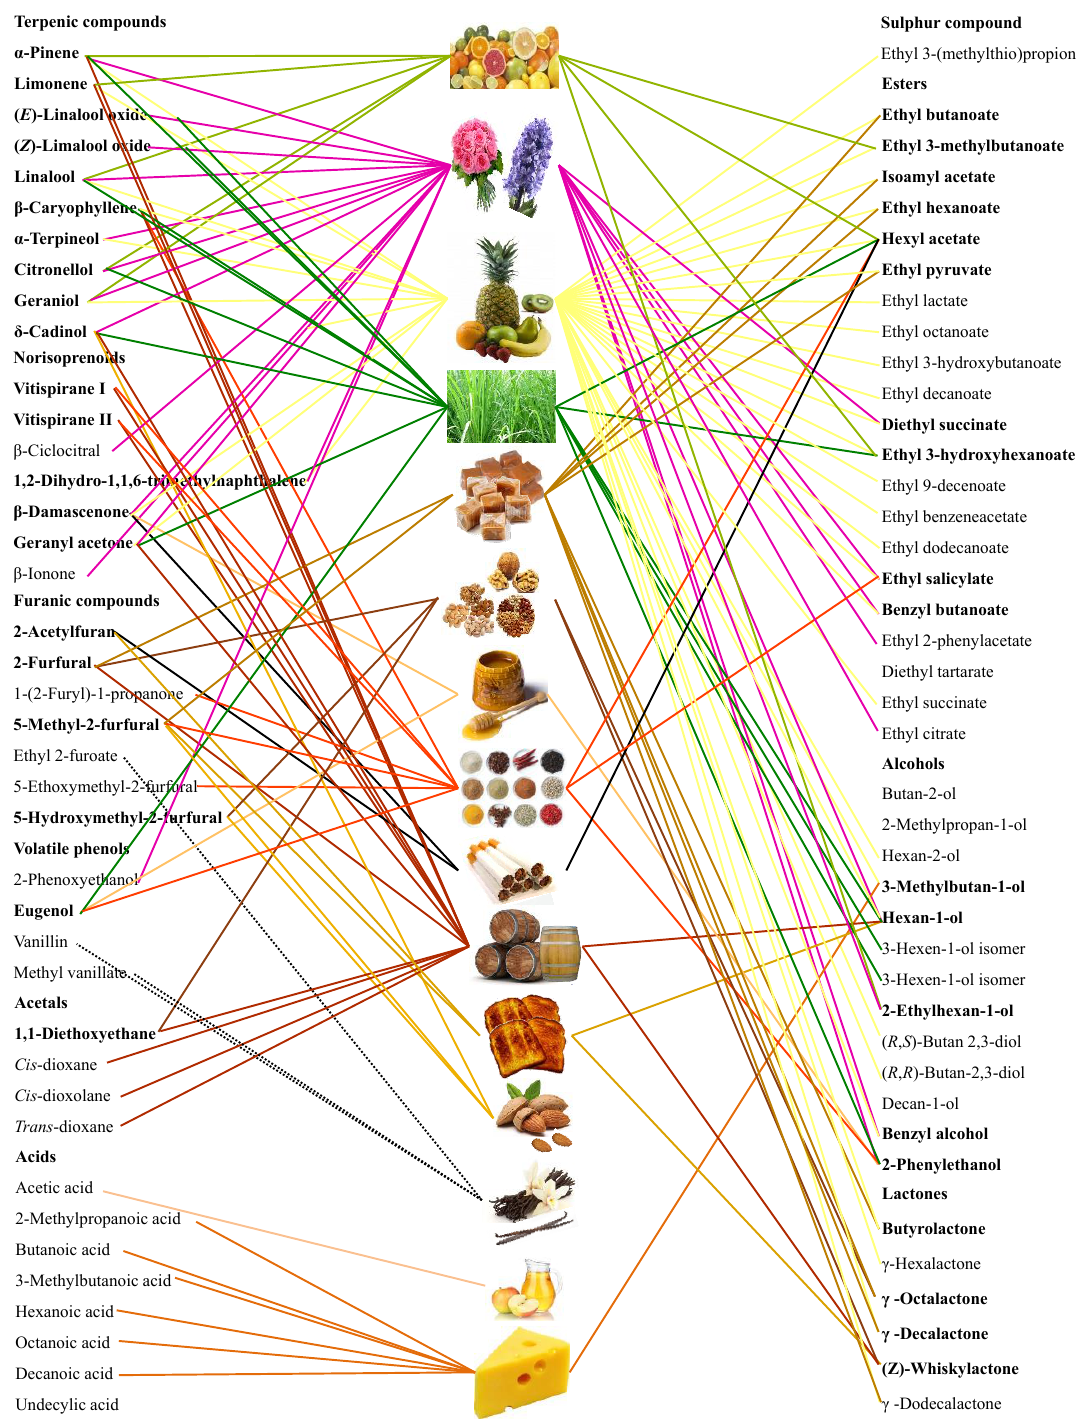
Figure 1. Madeira wine aroma notes (middle column), together with the chemical families (82 VOCs) that explain its aroma notes (left and right columns). Volatile compounds are shown in boldface if shared at least two or more aroma